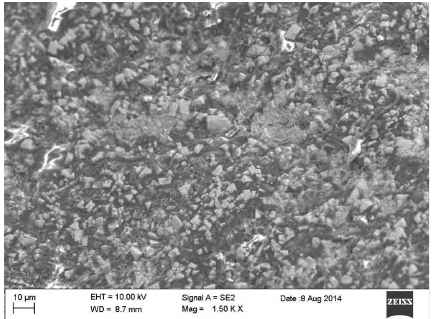
Figure 3: Crack on WC grain.